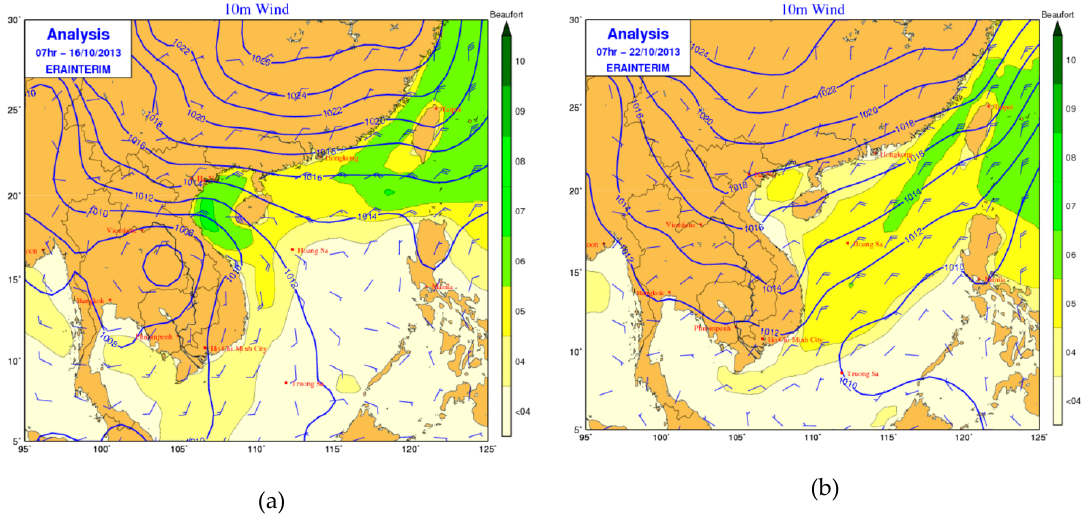
Geosciences 2018 , 8 , x FOR PEER REVIEW Figure 14 . Wind and pressure re-analyzed on( a )16 October 2013 and ( b ) 22 October 2013. Figure 14. Wind and pressure re-analyzed on ( a ) 16 October 2013 and ( b ) 22 October 2013.